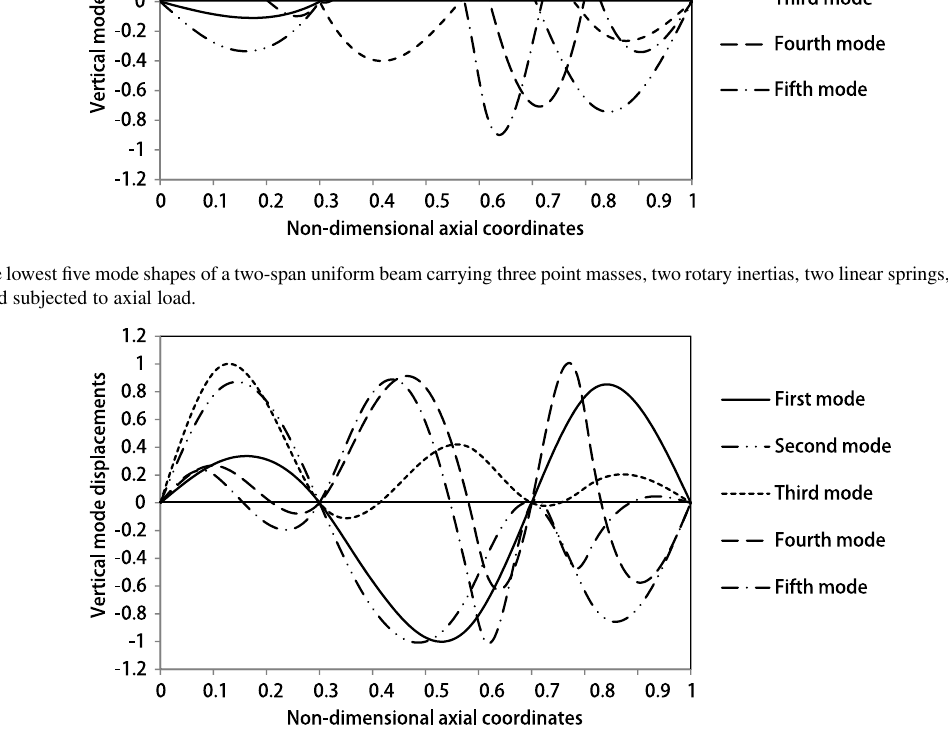
Fig. 6. The lowest five mode shapes of a three-span uniform beam carrying three point masses, two rotary inertias, two linear springs and two rotational springs and subjected to axial